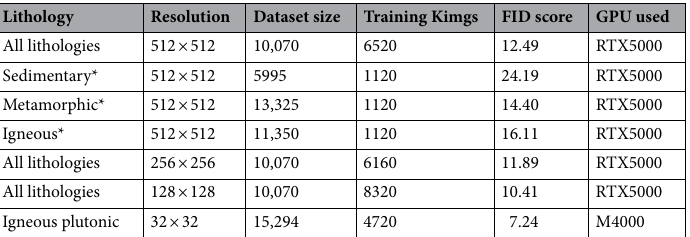
Table 5. Value of FID scores obtained on different lithologies and dataset sizes. Models in boldface were trained from scratch *models trained using transfer learning applied to all lithologies 512x512 model.